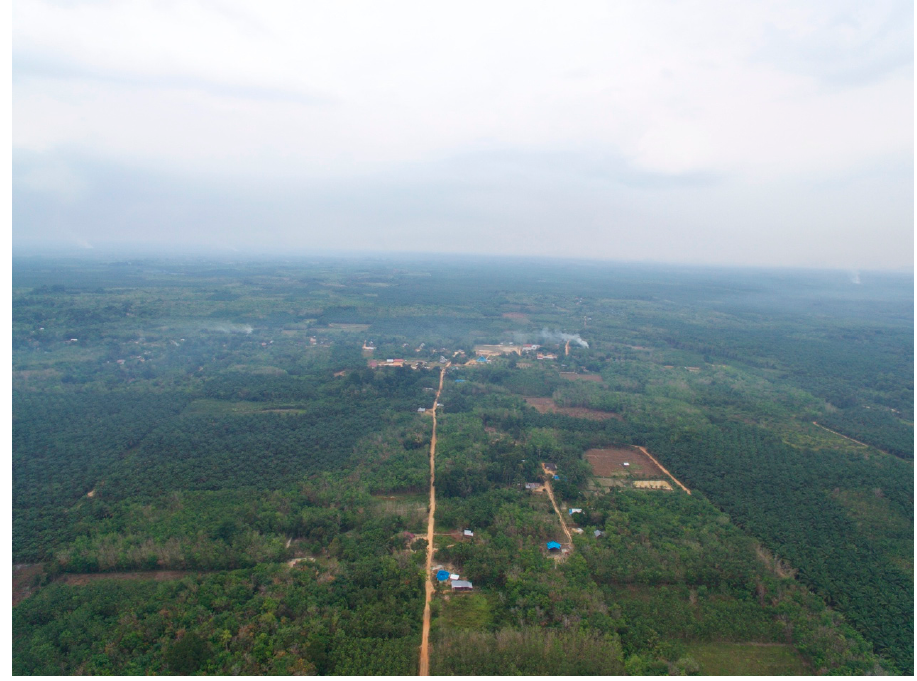
Figure 1. Mosaic of land uses including oil palm and rubber surrounding Kenyabur Baru.